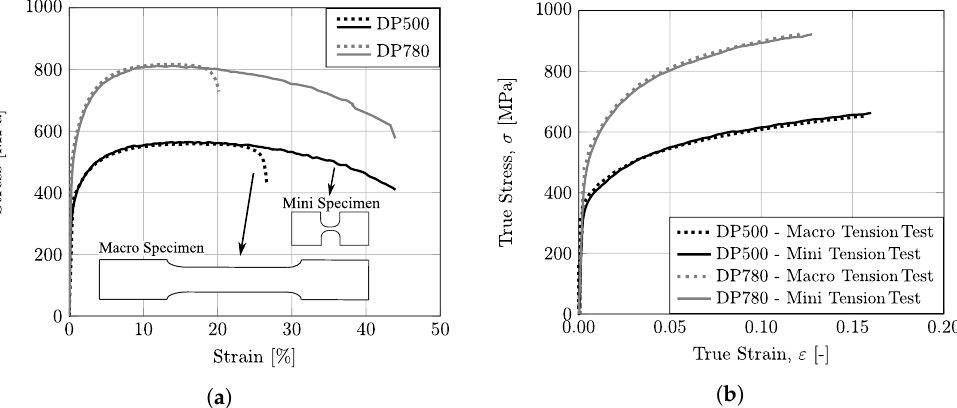
Figure 7. Experimental tensile stress/strain behavior for DP500 and DP780 steels: ( a ) engineering stress–strain curves; ( b ) true stress–strain